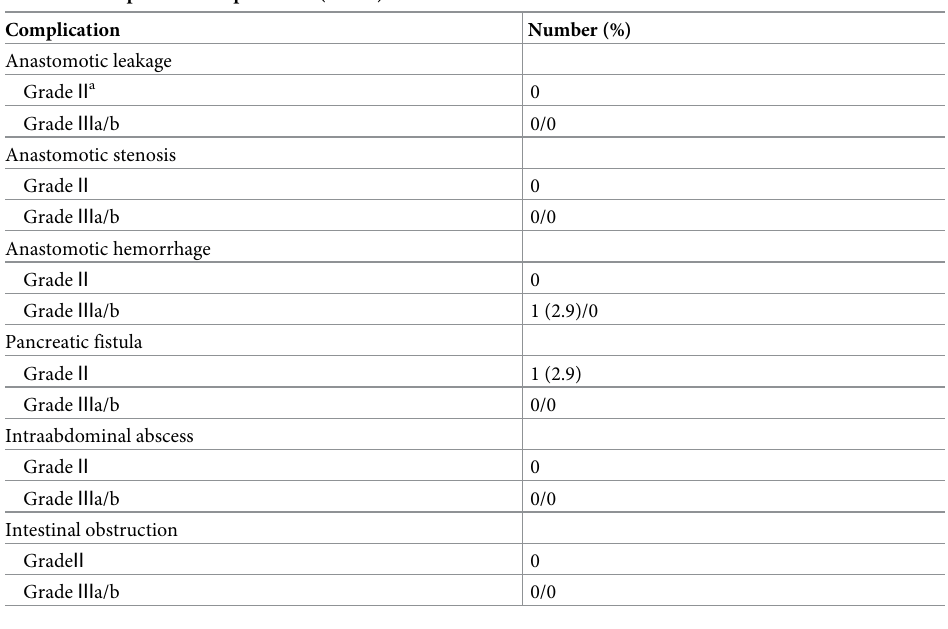
Table 2. Postoperative complications (n =